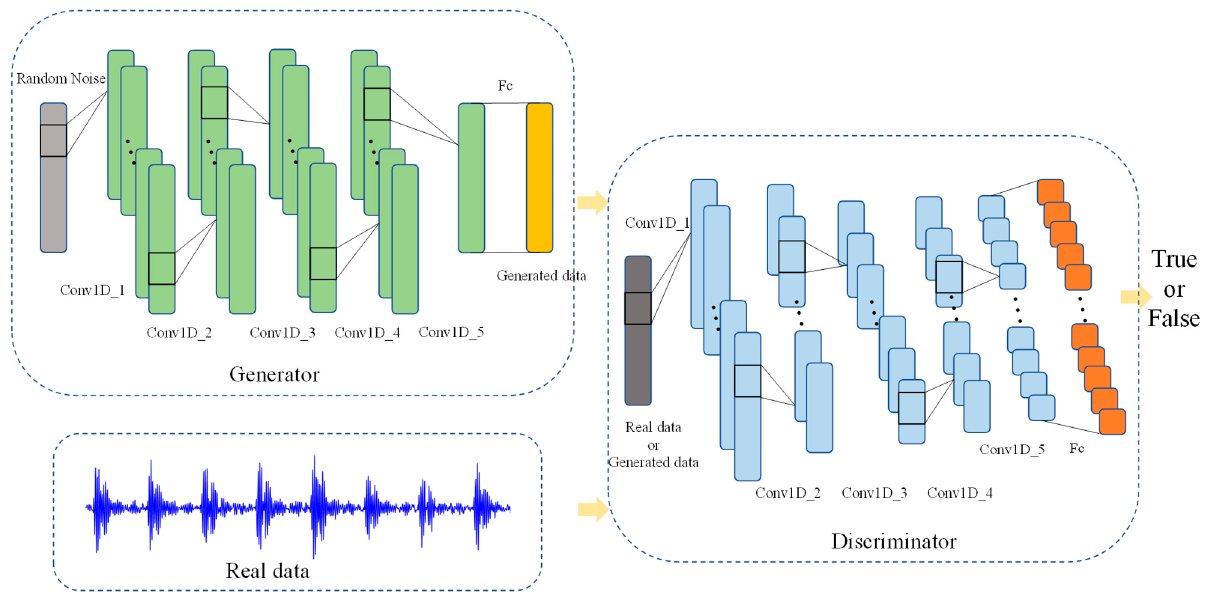
Figure 8. The 1D-DCGAN structure Figure 8. The 1D ‐ DCGAN structure diagram.